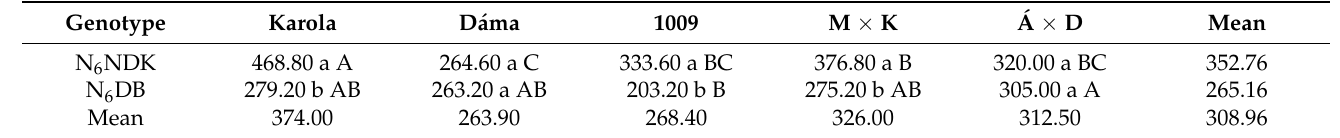
Table 2. The effect of different growth regulators on the number of AC-derived calli/100 anthers. The different lower-case letters (a, b) denote significantly different values ( p < 0.05) between the treatments (LSD 5% = 52.206), while the different capital letters (A, B, C) denote significantly different values ( p < 0.05) among the genotypes (LSD 5% = 82.559).